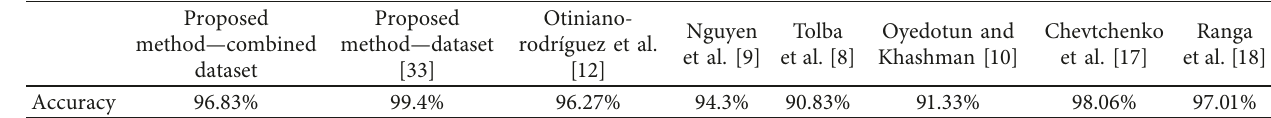
Table 6: Comparison with related